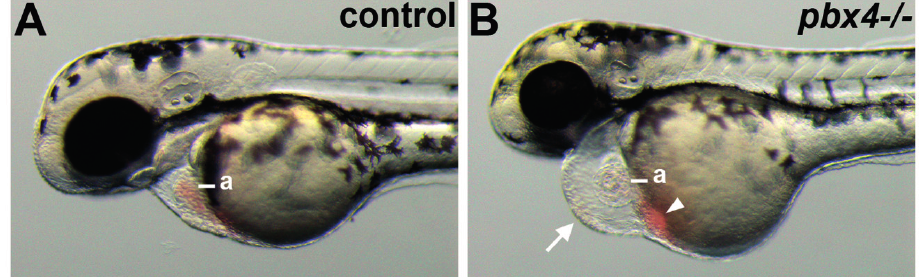
Figure 1. Defective heart development in pbx4 mutant embryos. ( A , B ) Lateral views of live ( A ) control and ( B ) pbx4 b557 -/- embryos at 50 h post fertilization (hpf). pbx4 b557 mutant embryos show pericardial edema (arrow in B ) and blood pooled near the atrium (arrowhead in B ). a, atrium. For controls, n = 23. pbx4 b557 mutant embryos ( n = 20) all show similar phenotypes as in ( B ). Anterior is to the